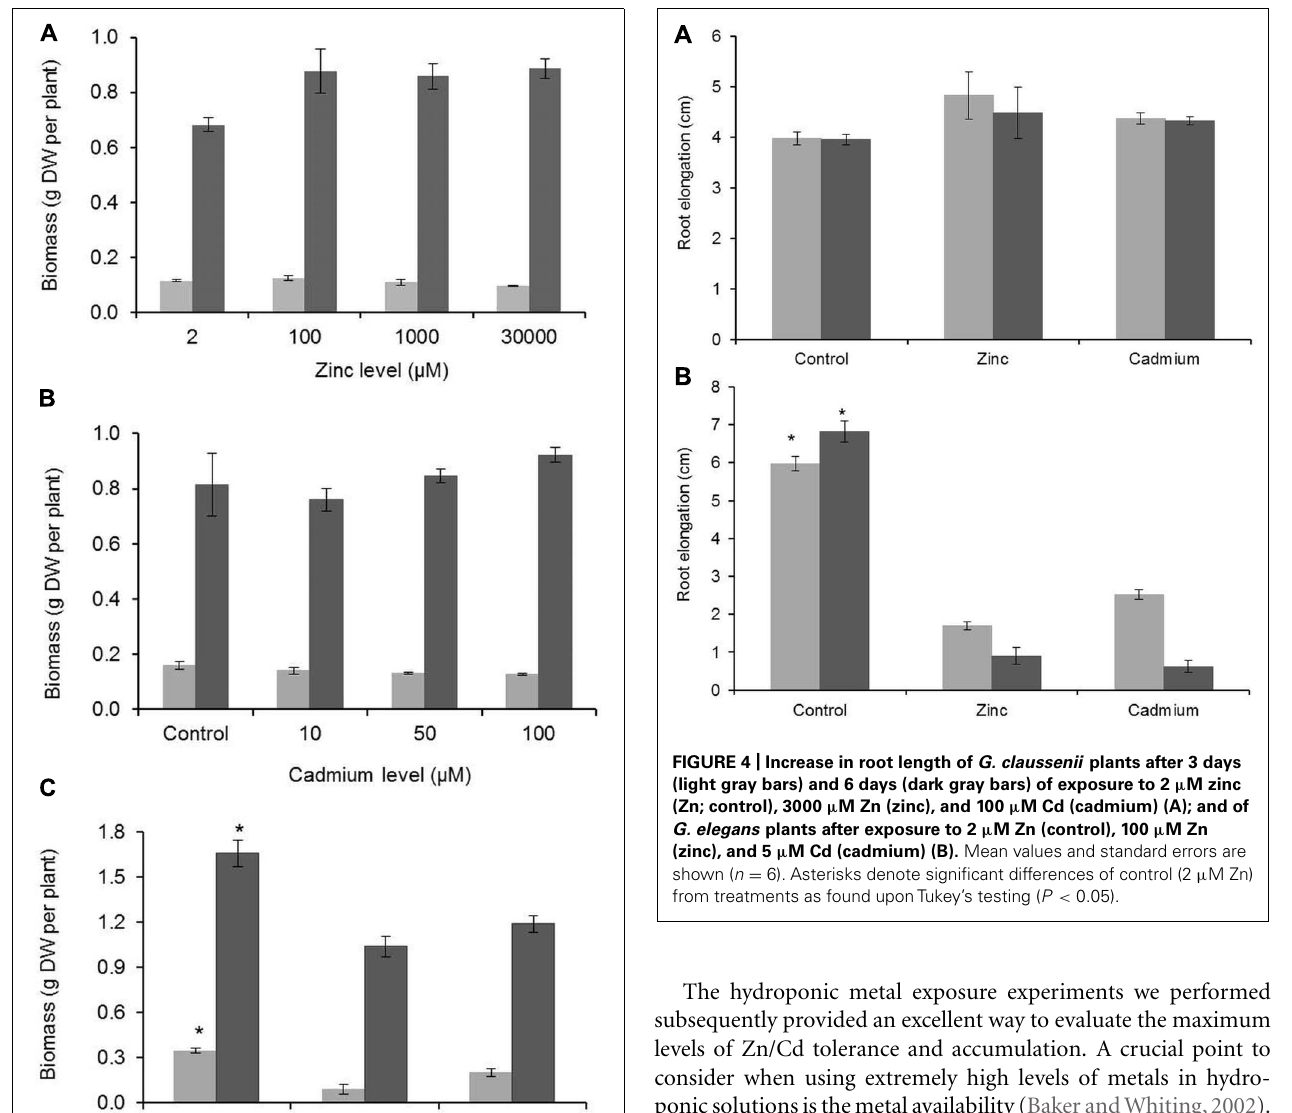
Cd concentrations of G. claussenii plants grown on contaminated soil collected at the site (maximum 5300 and 280 μ g g − 1 for Zn and Cd, respectively; Table 1 ) clearly exceed the recently proposed threshold levels to classify species as metal hyperaccumulators, which are 3000 μ g Zn g − 1 dry weight and 100 μ g Cd g − 1 dry weight (van der Ent et al., 2012). This means G. claussenii is not only a metallophyte, but also a Zn/Cd hyperaccumulator species, again the first one known from the South American continent.